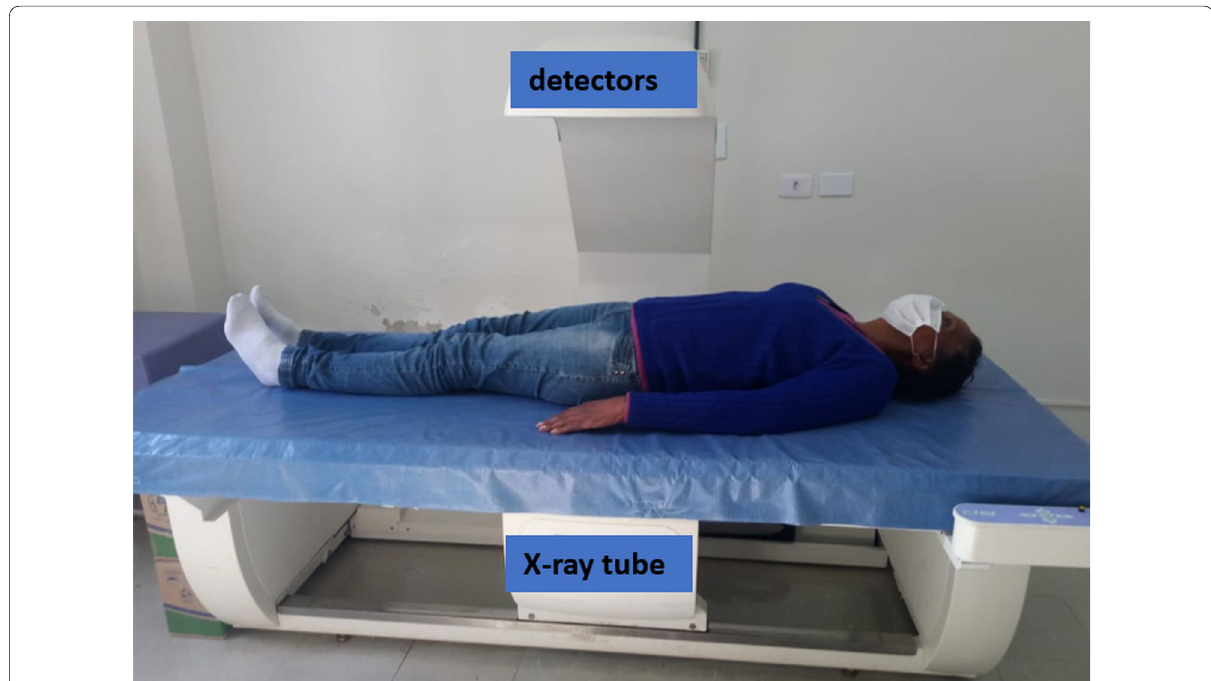
Fig. 5 Fundamental principles of dual‑energy X‑ray absorptiometry (DXA): the X‑ray source located at the base of the equipment emits high and low energy X‑ray beams that are captured by the detectors for assessment of interaction and differences between the three compartments evaluated by DXA